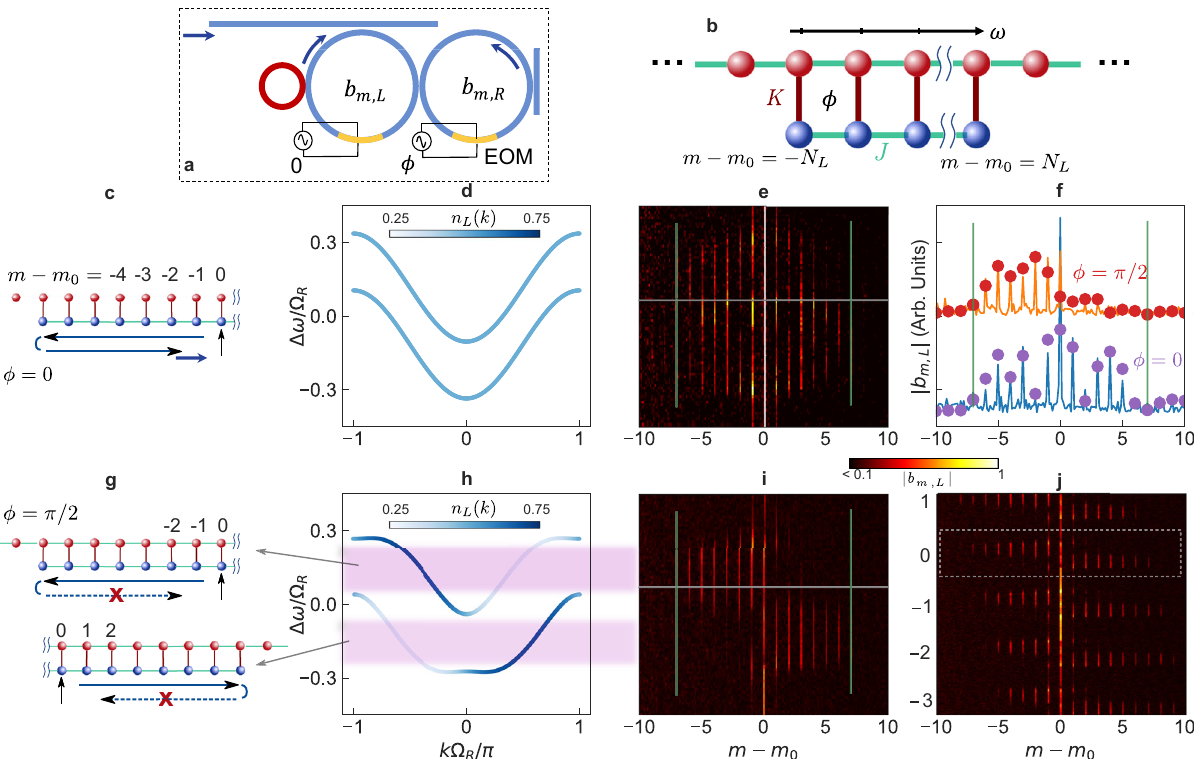
Fig. 5 Interaction of quantum Hall ladder with boundaries. a Two-leg quantum Hall ladder was constructed using two coupled rings, both of which are modulated with a phase difference ϕ between the two modulations. The auxiliary ring (red) introduces a boundary in the synthetic frequency dimension of the left ring, corresponding to a fi nite lower leg of the ladder in ( b ). b Shows a lattice model for ( a ). Coupling constants J and K are determined by the modulation amplitude in ( a ) and the evanescent coupling rate between the rings. c Schematic of the lattice excitation and its dynamics along the frequency dimension for the trivial case ϕ = 0. The wave propagates along the frequency axis, reaches the boundary, and gets re fl ected, forming fringes in the steady- state intensity distribution. d Bulk band structure of the ladder for ϕ = 0, showing symmetric bands with no chirality. e Measured lattice space occupation, showing fringes due to re fl ection from the boundary and bidirectional propagation. The fringes are clearly visible in the blue line cut in ( f ) taken at Δ ω / Ω = 0.11. Purple dots in ( f ) represent Floquet scattering matrix simulation results. g – i Same as ( c – e ) but for the nontrivial topology case ϕ = π /2. Chiral R one-way modes are visible in ( h ) [colorbar represents the strength of localization on the ladder's lower leg, n L ( k ) = ∣ b L ( k ) ∣ 2 ]. Pink shaded regions depict energies with one-way modes, as veri fi ed experimentally in ( i ). Back-re fl ection is inhibited (schematics in ( g )), leading to unidirectional propagation and no fringes despite the presence of a boundary, as visible in the orange line cut in ( f ). Red dots are simulation results. j Same as i but over a larger range of input laser detuning, showing the steady state for exciting various frequency sites. The boxed region corresponds to ( i ), near Δ ω = 0. For Δ ω / Ω R near { − 3, − 2, Δ ω / Ω R and are shared with ( d ) and ( h − 1, 1}, the input mode m 0 is also shifted by the same amount. y-axis labels in ( e ) and ( i ) represent